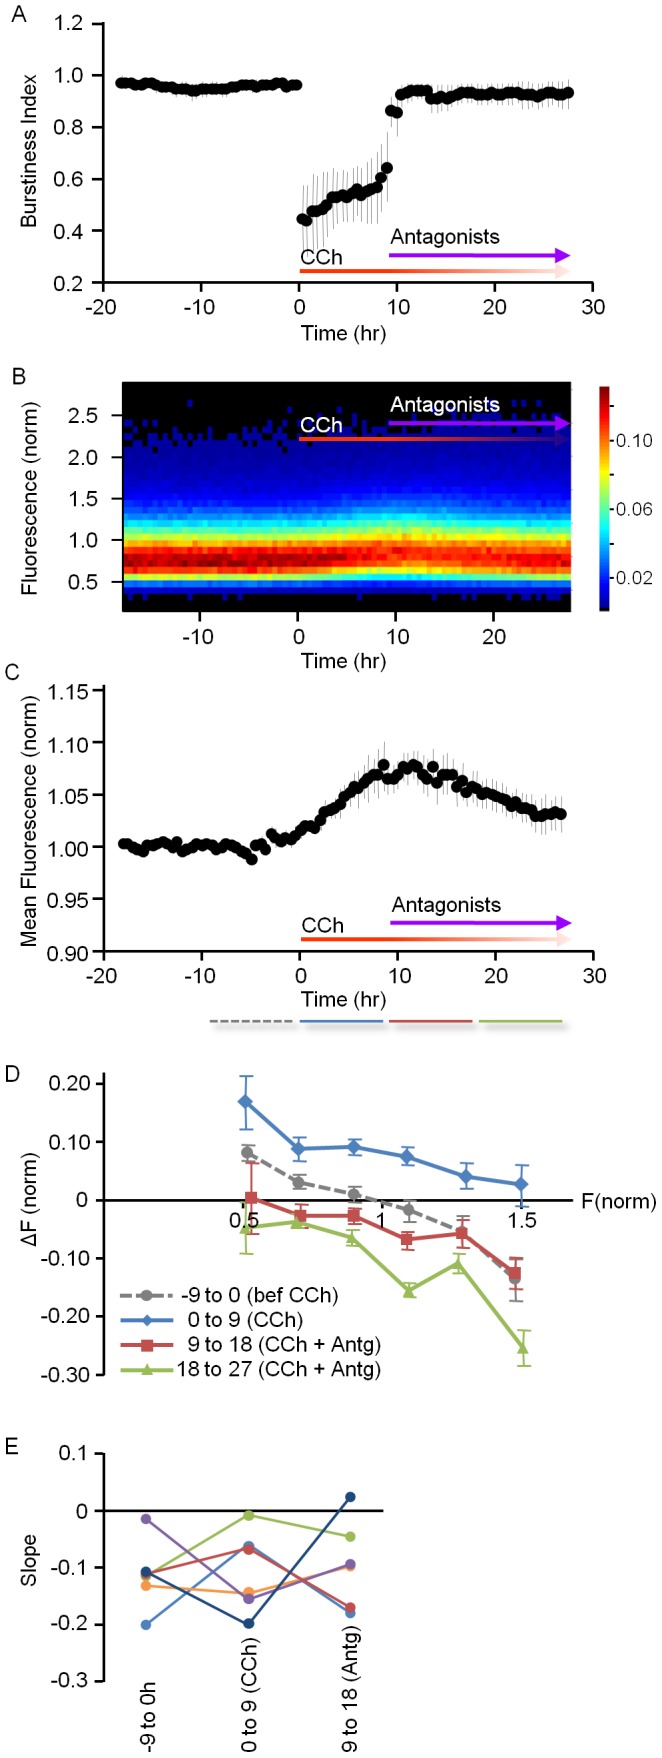
Rapid recovery of synchronous bursting and reversal of synaptic growth is observed after abrupt blocking of cholinergic receptors.9 hours after the application of CCh, Atropine (1 µM), and Mecamylamine (1 µM) were added to the MEA dishes and the perfusion media. Data pooled from 3 experiments. A) Burstiness index. B) PSD-95:EGFP puncta fluorescence distribution (27 sites, 26 neurons) and C) Mean PSD-95:EGFP puncta fluorescence. D) Normalized, pooled and binned ΔF vs. F0 plots for individually tracked synapses (674 puncta from 6 neurons from 3 separate experiments) before CCh (dashed line), after CCh application (blue line) and antagonist application (red and green lines). Note that both CCh and the antagonists mainly affected the intercepts of these plots, whereas the slopes were less affected. E) Changes in the slopes of ΔF vs. F0 linear regression fits between consecutive time windows before CCh, after CCh application and after antagonist application plotted for each cell separately. Note the lack of consistent trends. Data in A,C,D, mean ± SEM.